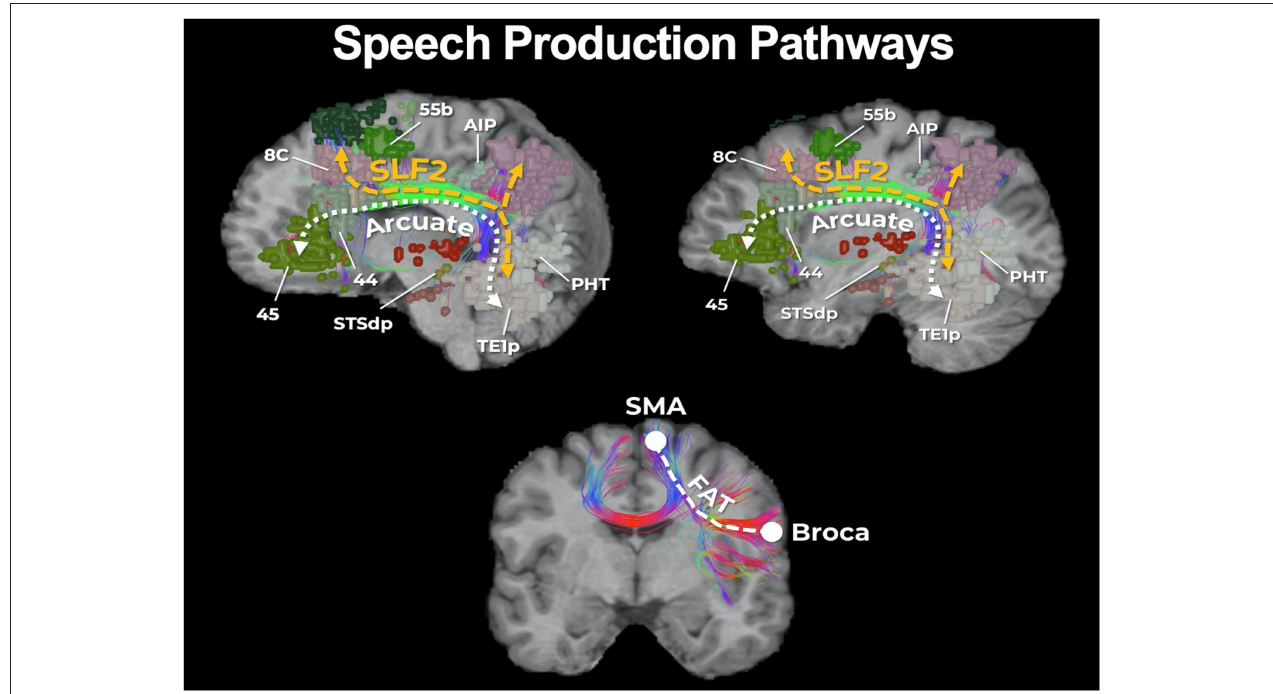
FIGURE 6 | Core parcellations and fibers involved in speech production. It is important to be aware of the core parcellations involved in speech production, as well as the main fibers interconnecting those regions such as the second layer of the superior longitudinal fasciculus (SLF-II), the arcuate fasciculus (AF), and the frontal aslant tract (FAT). For instance, area 55b is a recently discovered region that increasing evidence has suggested is necessary for phonation and motor control of the larynx ( 90). 55b is connected to the posterior temporal language areas via the SLF-II in the left hemisphere. If unaware of such connections, transgressing 55b leads to apraxia of speech